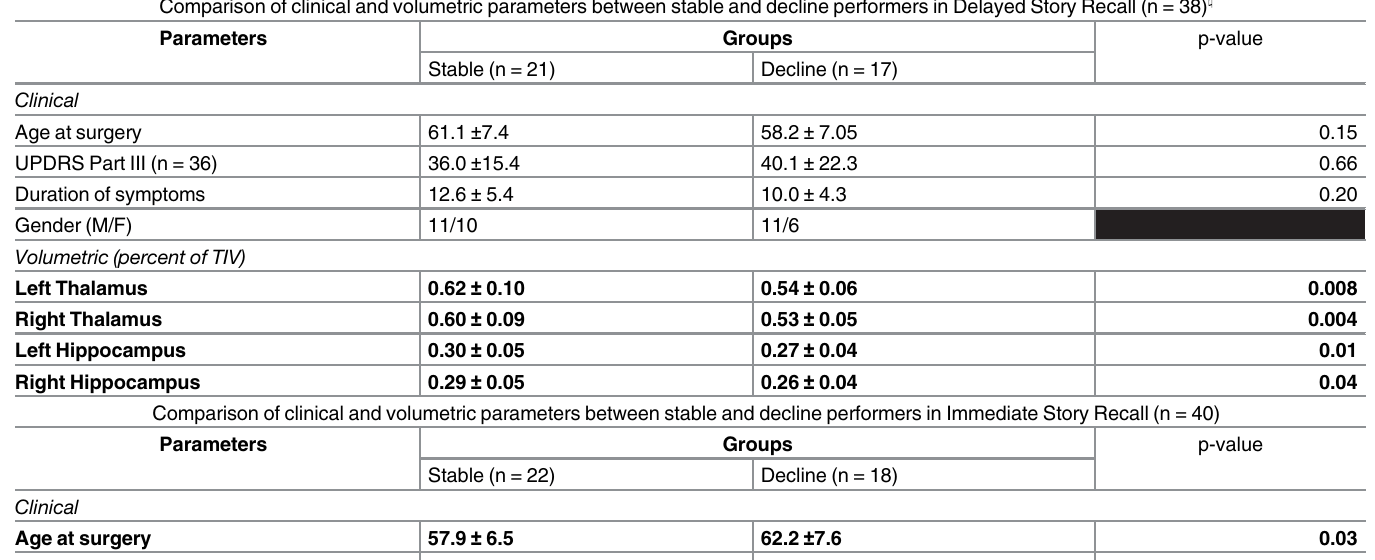
Table 4. Volumetric differences between stable and decline performers. Comparison of clinical and volumetric parameters between stable and decline performers in Delayed Story Recall (n = 38) \